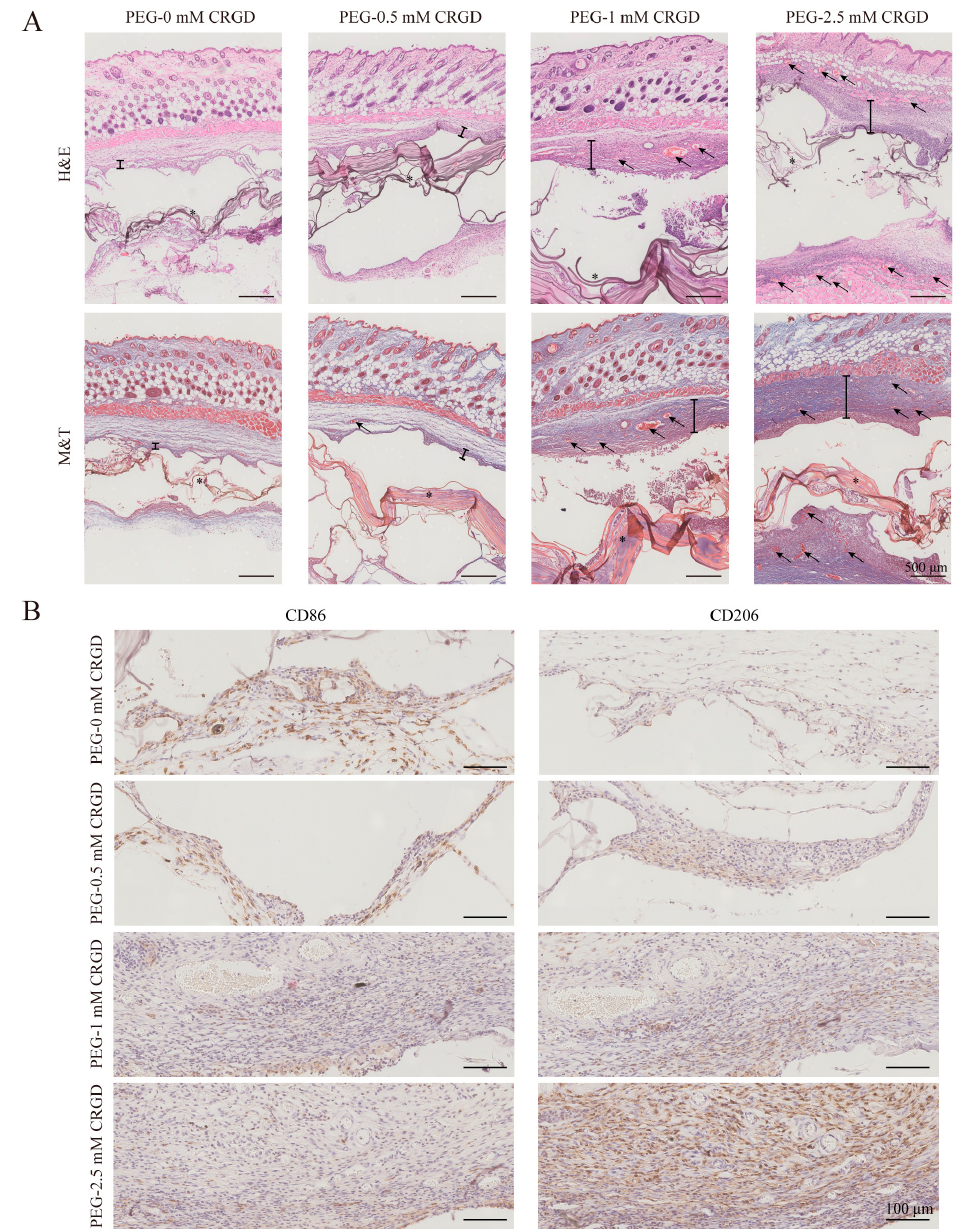
Figure 6. Macrophage polarization of PEG-CRGD hydrogels implanted in C57/BL6 mice. ( A ) H&E and M&T staining were used to evaluate the inflammatory response after 30 days implantation. Scale bars, 500 µm; * = hydrogels; “I” = the thickness of infiltrated inflammatory cells around the hydrogel; arrow = the representative new blood vessel tissue ( B ) Immunohistochemical staining to assess the phenotype of macrophages infiltrated into hydrogel–tissue interfaces on day 30 after implantation. Scale bars, 100 µm.